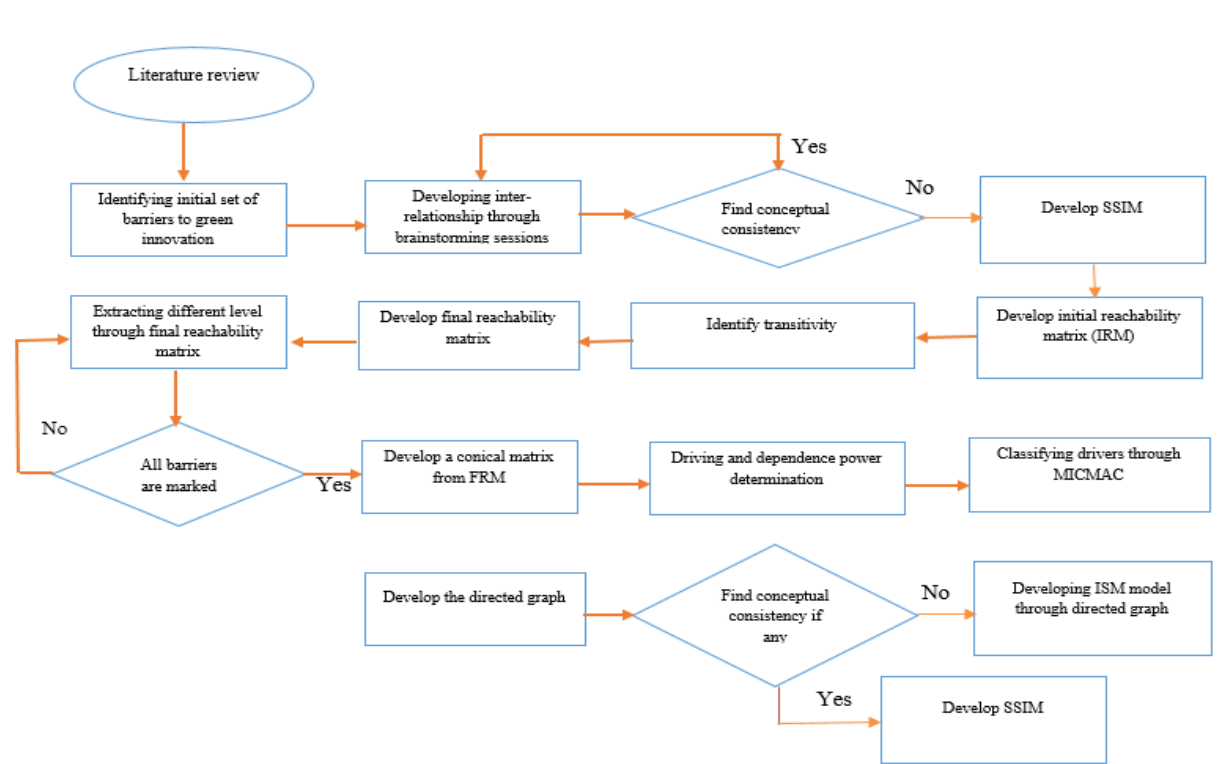
Figure 2. Application of ISM approach to develop an ISM model of green innovation barriers. Table 3. The contextual relationship of green innovation barriers were obtained from partici- pants. Table 3 presents’ different relationships symbols which are explained below by the